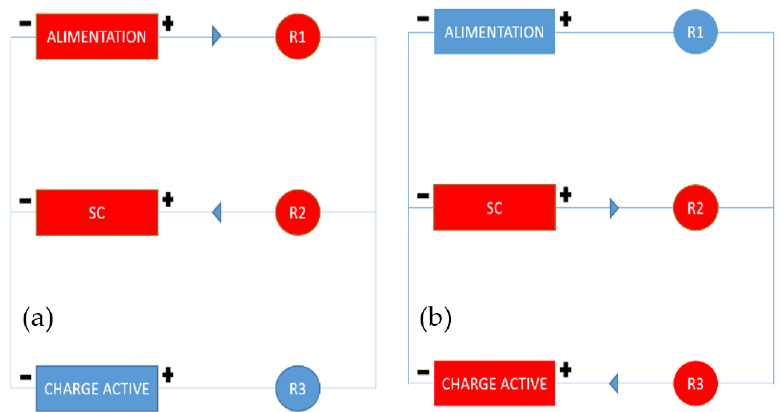
Figure 3. ( a ) Charging circuit and ( b ) discharging circuit.